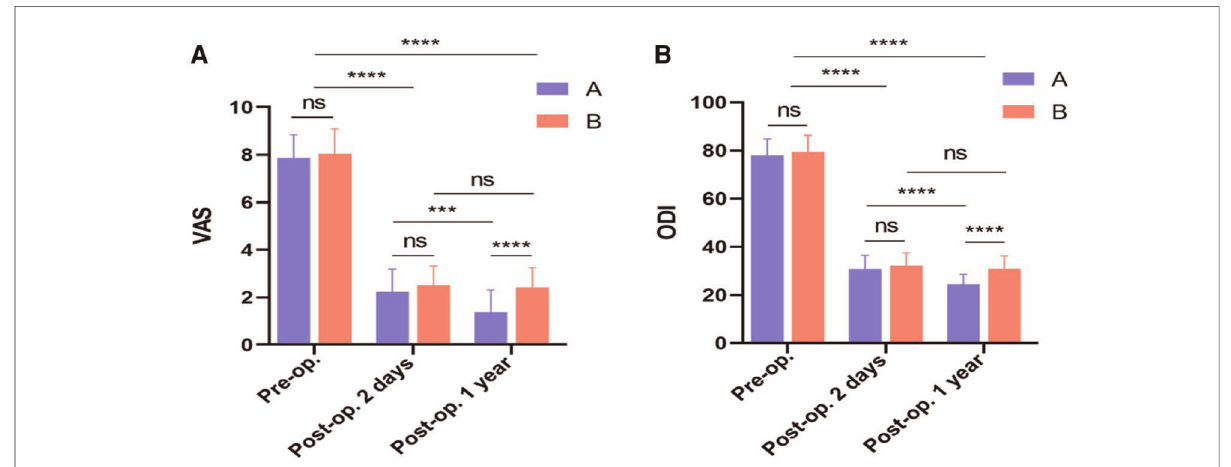
FIGURE 6 Clinical ef fi cacy. ( A ) Comparison of VAS between two groups. ( B ) Comparison of ODI between two groups. ***, P <0.001 vs. control; ****, P <0.0001 vs.